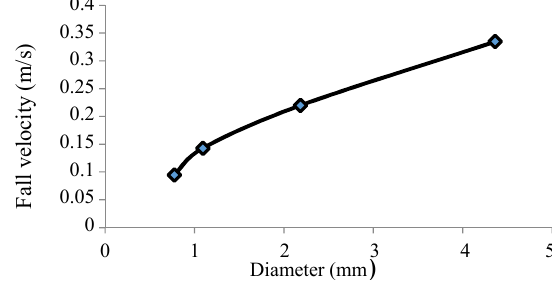
Fig. 10. Correlation of fall velocity and diameter in numerical data